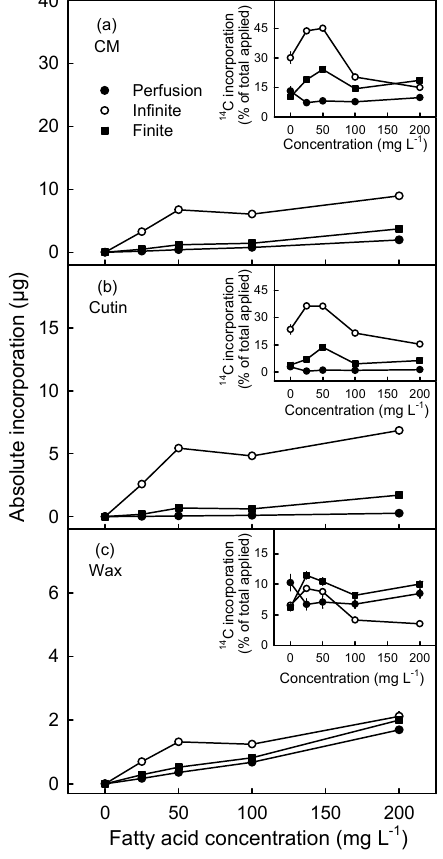
Figure 4. Effect of fatty acid concentration of feeding solution in the incorporation of 14 C in absolute amount (ng; main figures) and in relative amount (% of total applied; inset figures) in cuticular membrane (CM) ( a ), cutin ( b ) and wax ( c ). 14 C labelled oleic acid was applied to the excised exocarp segments (ES) of young ‘Idared’ apples, sampled at 83 days after full bloom (DAFB), using three different application methods. The concentrations of fatty acid in the feeding solutions were adjusted using un-labelled (cold) oleic acid. The values are means ± SEs of 15 replications.